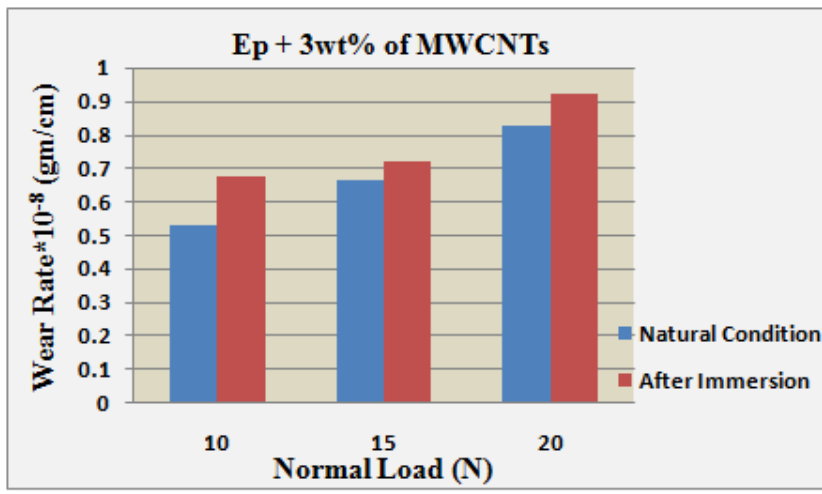
Fig. 7: Comparison between wear rate at natural condition and after